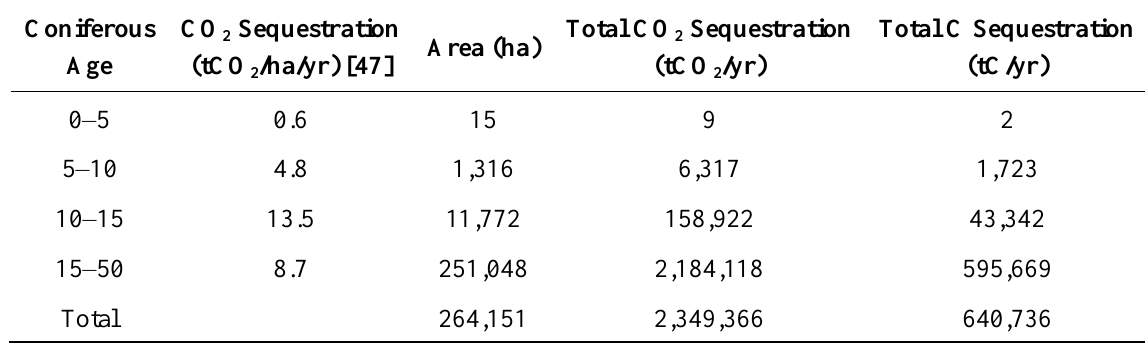
Table 6. CO sequestration by coniferous forests (cedar–cypress) per tree age using the 2 NDVI